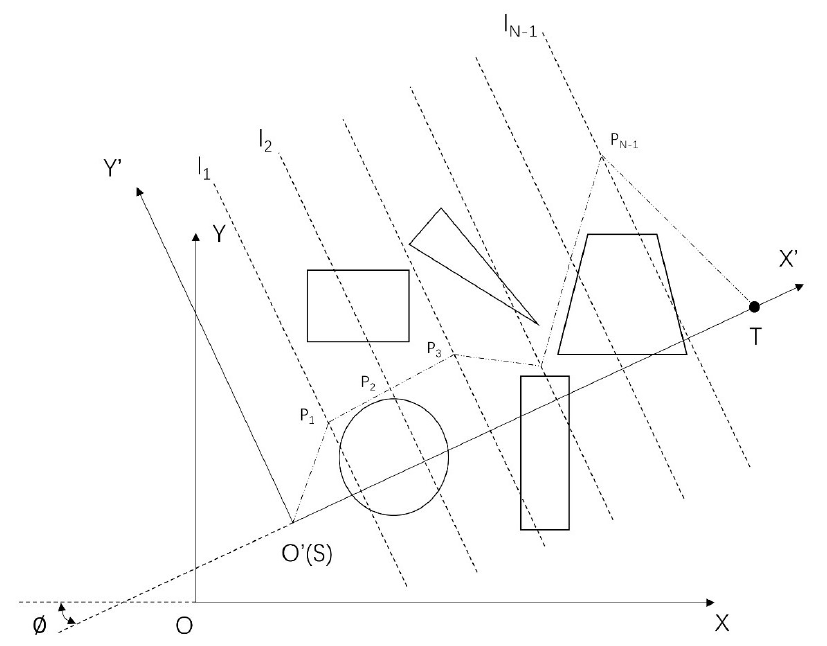
Figure 4. The coordinate transformation for path